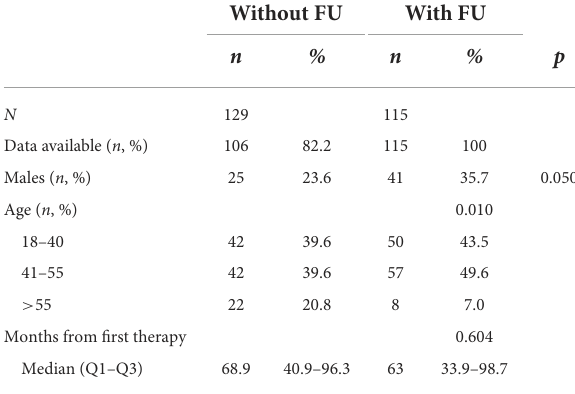
TABLE 2 Sample characteristics at baseline in patients with and without follow-up. Without FU With